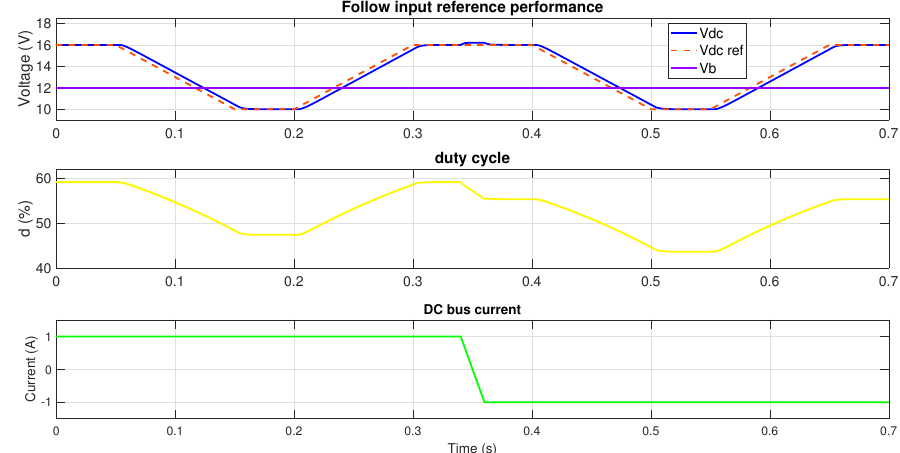
Figure 17. Reference tracking performance at V b = 12 V.